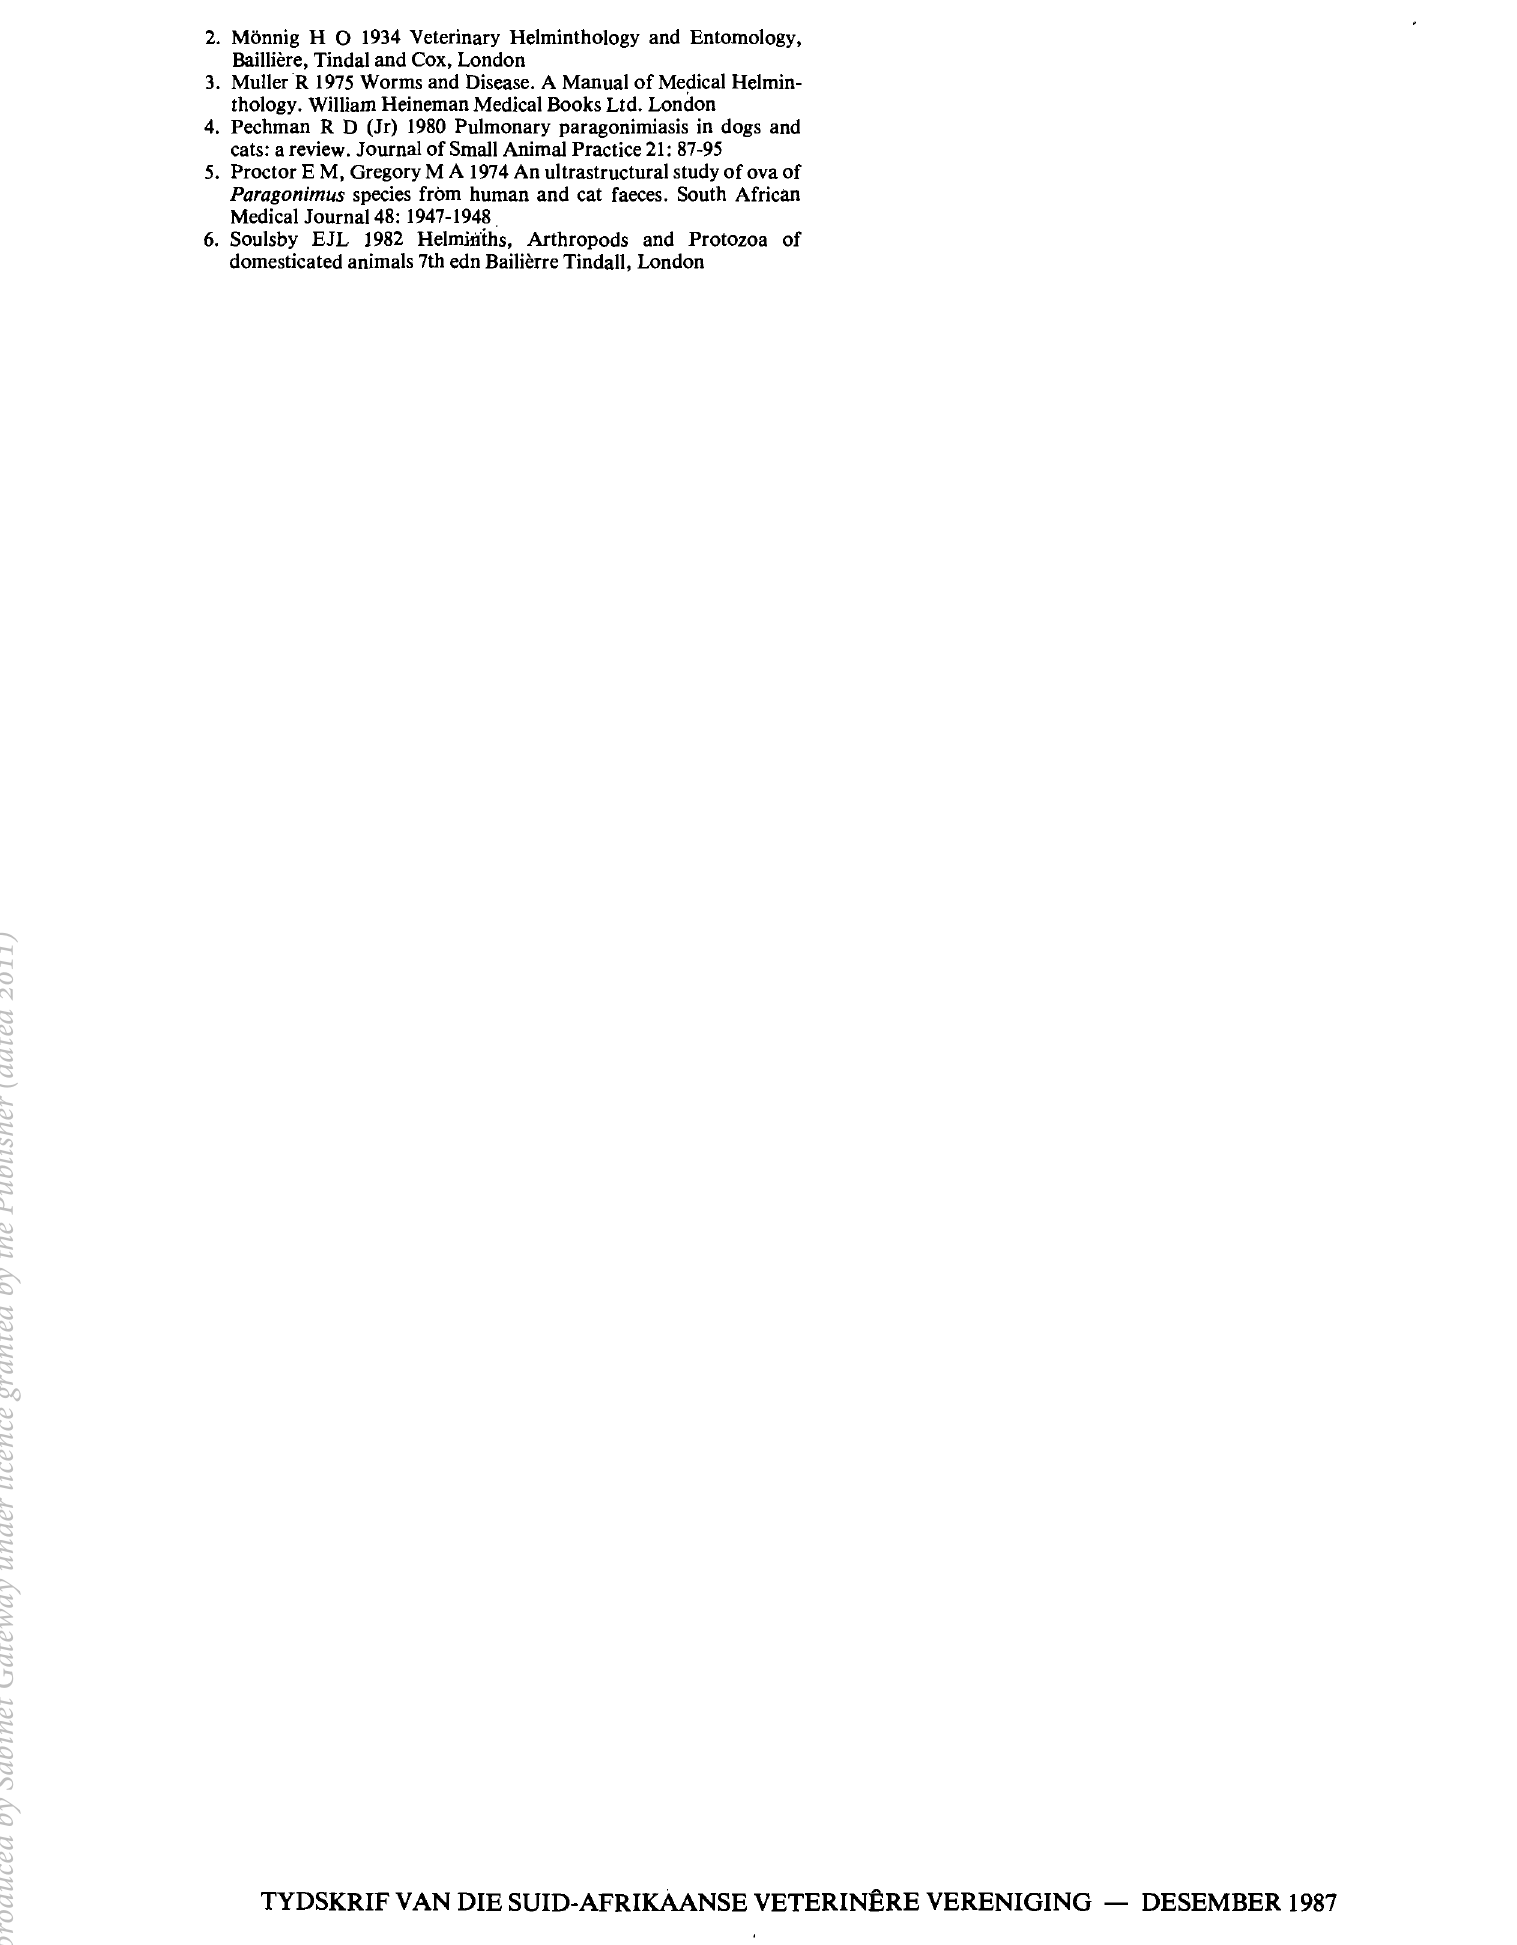
TYDSKRIF VAN DIE SUID-AFRIKAANSE VETERINERE VERENIGING - DESEMBER